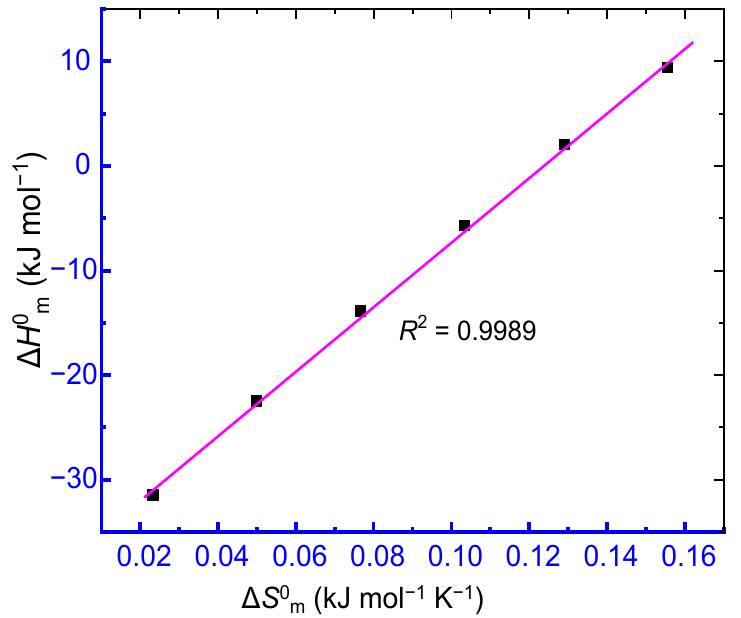
Figure 3. Enthalpy change vs. entropy change plot for the aggregation of CPC + 0.1% ( w / v ) PVP mixed system in water.